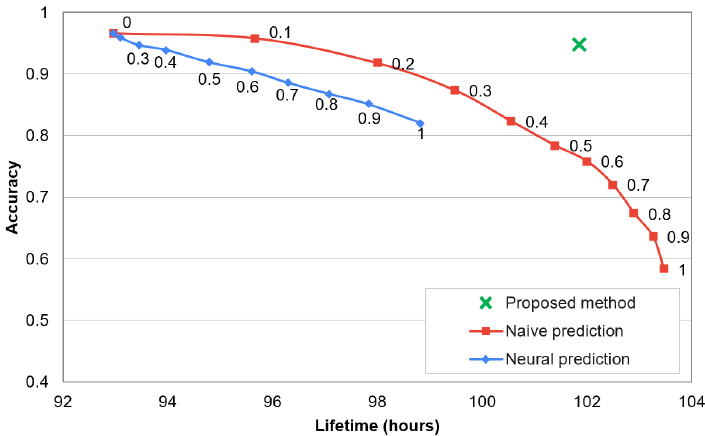
Figure 11. Accuracy of activity recognition vs. lifetime of sensor network.